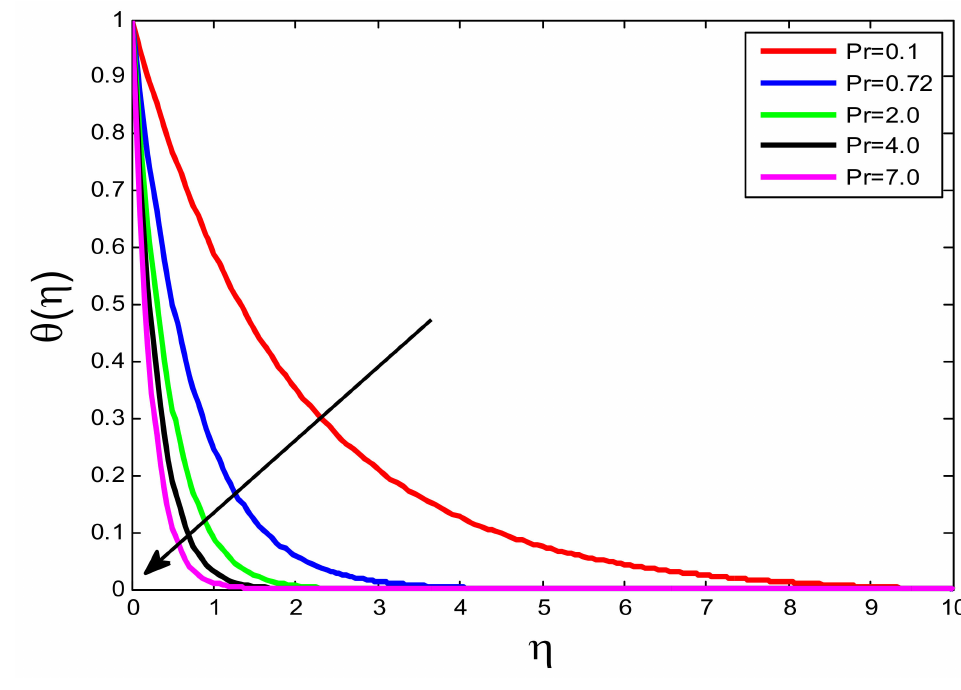
Figure 14. Influence of Pr on θ ( η ) .